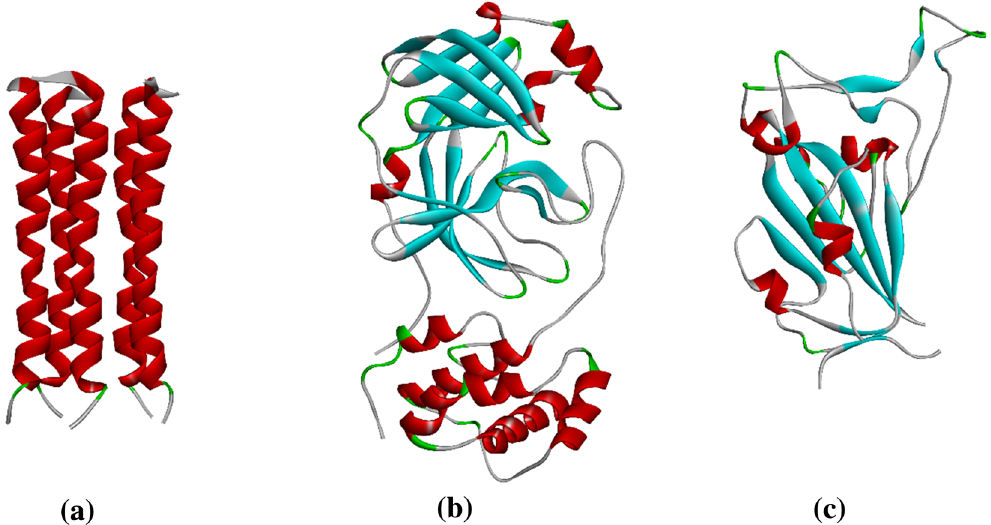
Figure 2. Macrostructures used: ( a ) E-pro; ( b ) M-pro ( c ) S-gly (Binding